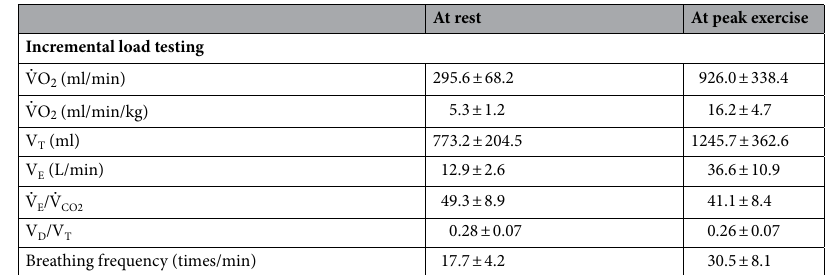
˙ VO 2 oxygen uptake,